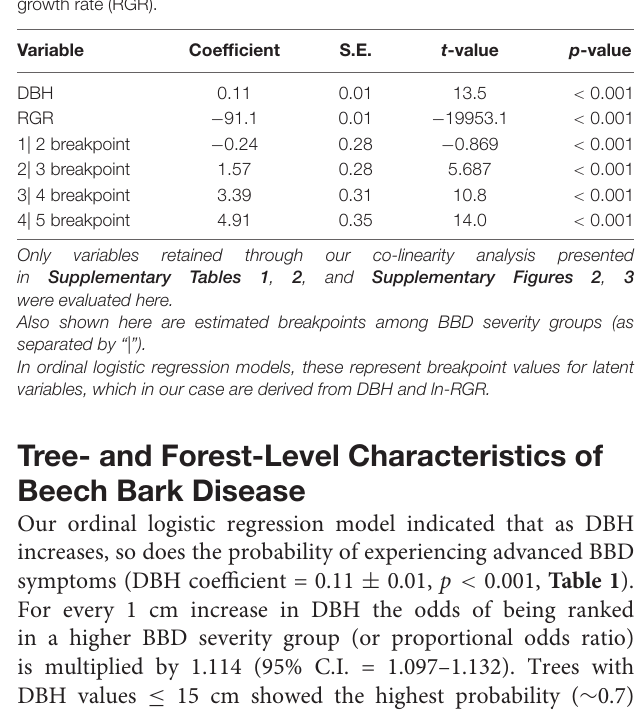
TABLE 2 | Summary of the accuracy of an ordinal logistic regression model including tree diameter (DBH) and relative growth rate (RGR) in predicting BBD severity ranking in beech